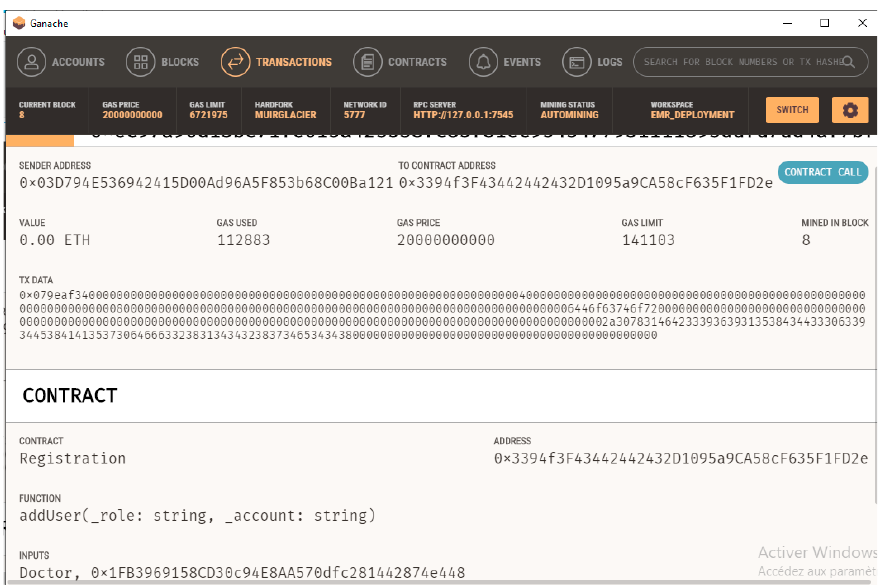
Figure 11. Registration smart contract deployed in Ganache.